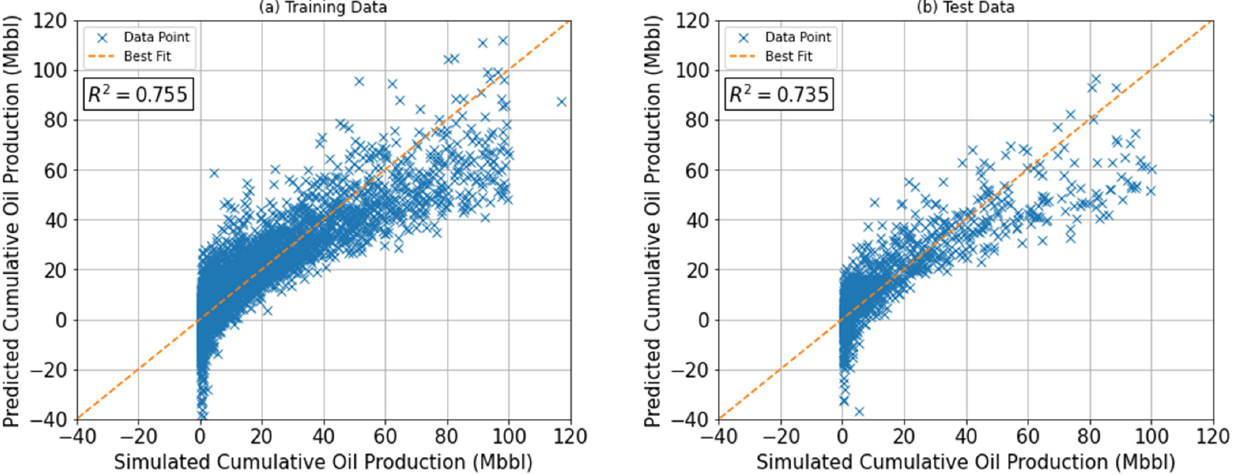
Figure 5. Predicted and simulated plot of ( a ) training data and ( b ) testing data for cumulative oil production—polynomial regression model.